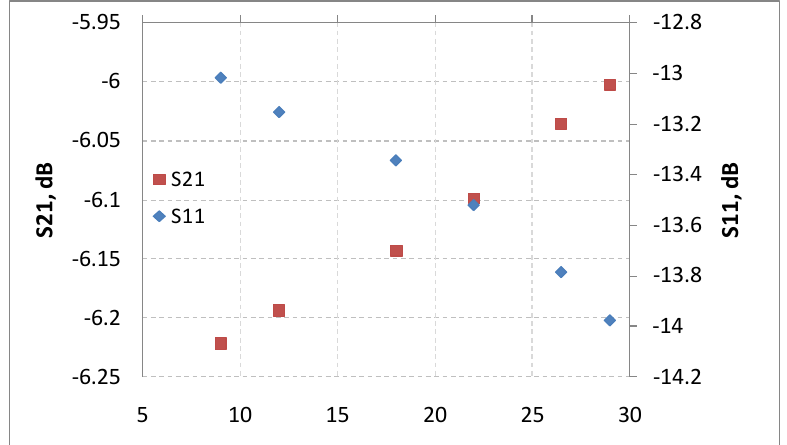
Figure 11. scattering parameters vs. applied voltage to the heaters, f = 20